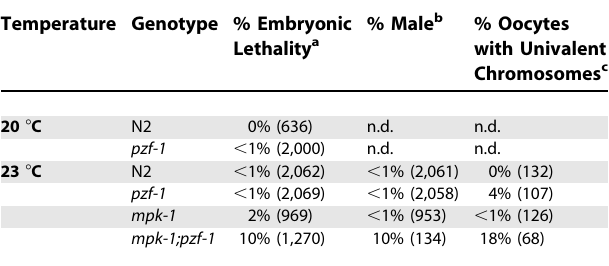
P 0 mothers were grown at 20 8 C or 23 8 C from L1 stage. Between six and 40 P 0 mothers were analyzed. a Percentage of dead embryos. Numbers in parentheses indicate total number of embryos laid. Embryoniclethality of mpk-1;pzf-1 was scored in multipleexperiments because of the small brood size. b Percentage of male progeny. Numbers in parentheses indicate total number of adult progeny. c Percentage of oocytes with greater than six DAPI staining bodies indicating univalent chromosomes. Numbers in parentheses indicate total number of oocytes scored over three independent experiments. Three of four abnormal oocytes in the pzf-1 mutant were foundin asingleanimal.Such rare animalswere inadvertentlynot includedin the lethality and male analysis, resulting in lower percentage phenotypes. n.d., not